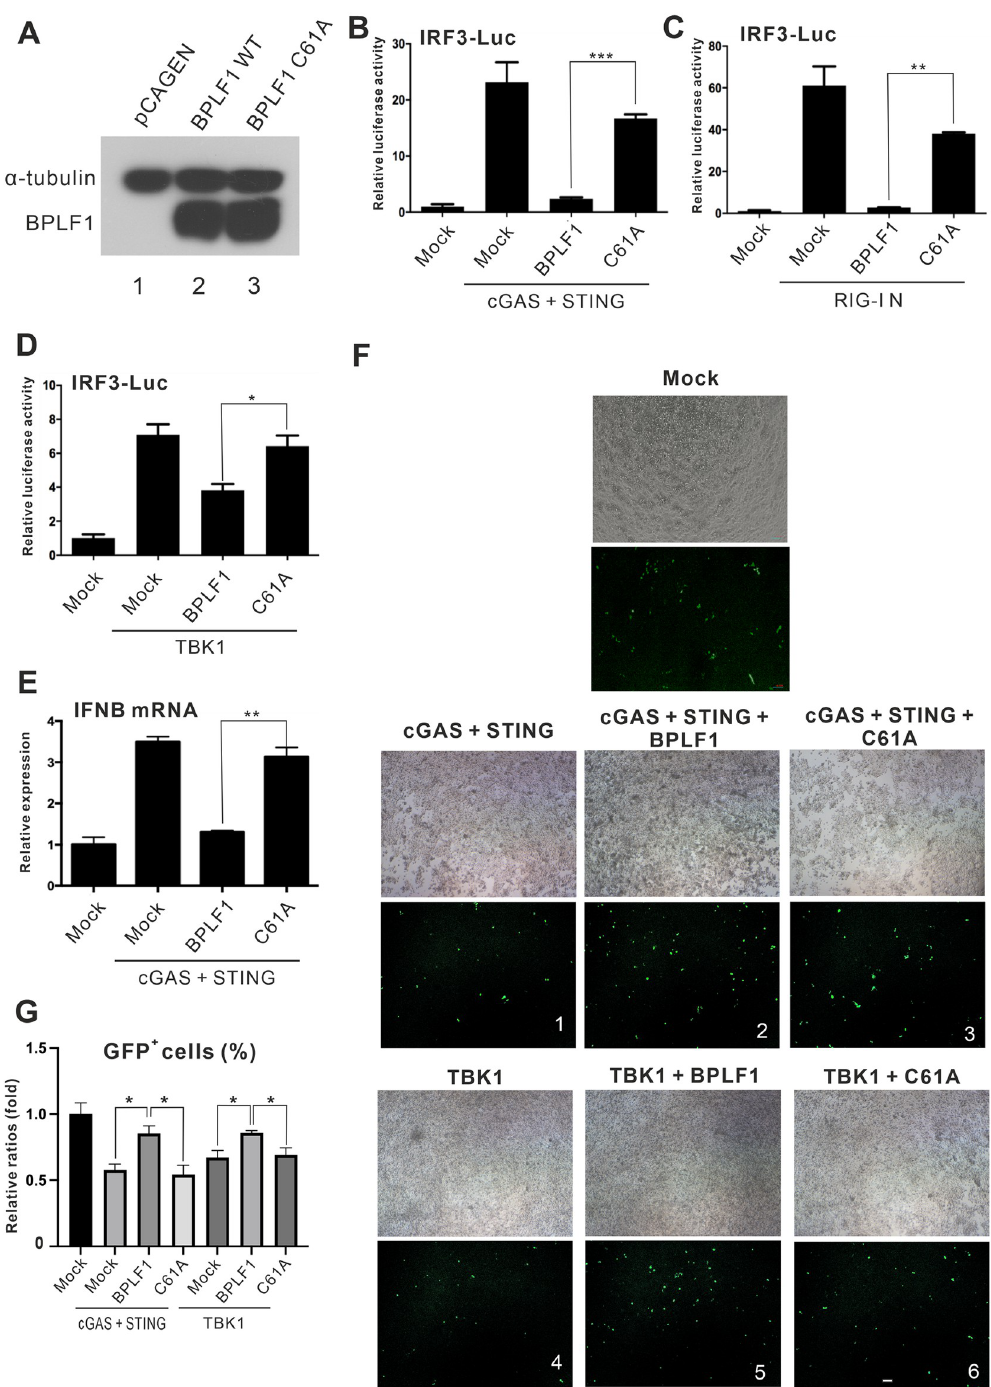
Fig 3. Requirement of deubiquitinase domain (DUB) for IFN-inhibitory effect of BPLF1. (A) Expression of BPLF1 C61A mutant. BPLF1 WT and C61A were transiently expressed in HEK293 cells. Endogenous α -tubulin was used for normalization. (B-D) IRF3 activation by C61A mutant. The indicated combinations of BPLF1 expression plasmid, mutant C61A expression construct as well as IRF3-Luc and TK-Luc reporter plasmids were transfected into HEK293 cells together with cGAS + STING (B), RIG-I N (C) or TBK1 (D) expression plasmids. Cells were harvested 24 hours post-transfection for dual-luciferase assay. (E) Effect of C61A on IFN- β induction. HEK293 cells were transfected with cGAS, STING, BPLF1 and mutant C61A expression plasmids. The total cellular RNA was harvested 48 hours post-transfection and the IFN- β transcripts expression levels were measured by RT-qPCR. The IFN β transcript expression levels were normalized to those of endogenous